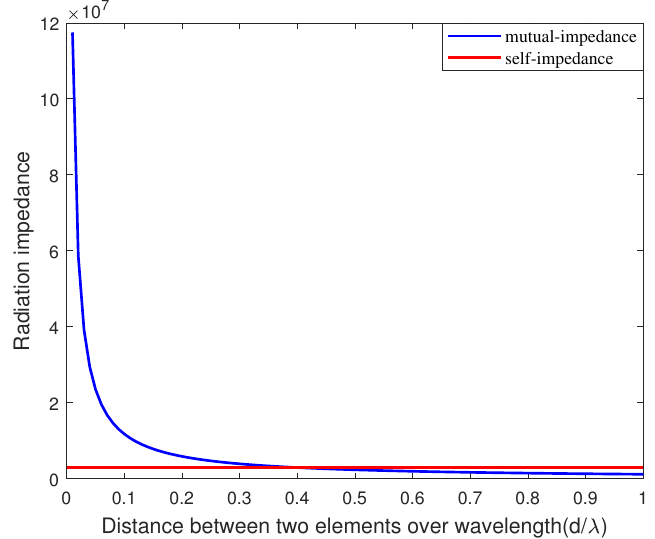
Figure 19. Curve of the radiation impedance changing with the array element